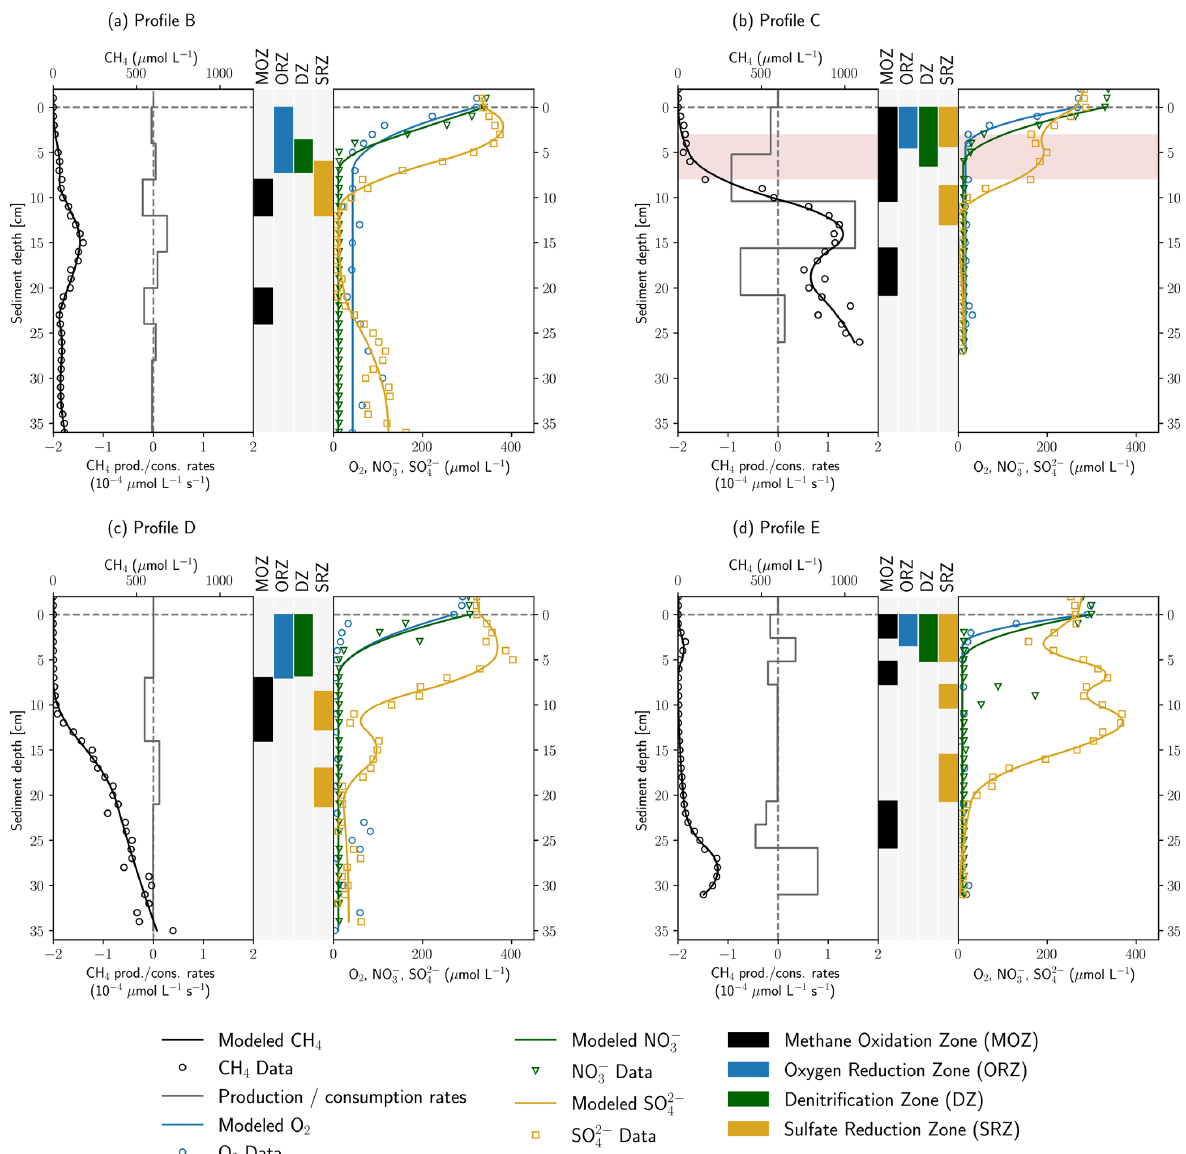
Figure 4. Results of concentration gradient modeling using the PROFILE software for profiles B–E. In panels (a) – (d) , the left side shows modeled and measured CH 4 concentrations as well as modeled CH 4 production and consumption rates. In the center, the depth ranges of MOZ, ORZ, DZ and SRZ are highlighted. Zones with very low consumption rates ( < 5 × 10 − 6 µmolL − 1 s − 1 ) were not identified. On the right, measured and modeled O 2 , NO − and SO 2 − concentrations are shown. Rates are not displayed for electron acceptors for reasons of 3 4 clarity. Red background color in panel (b) highlights an enrichment in δ 13 C–CH 4